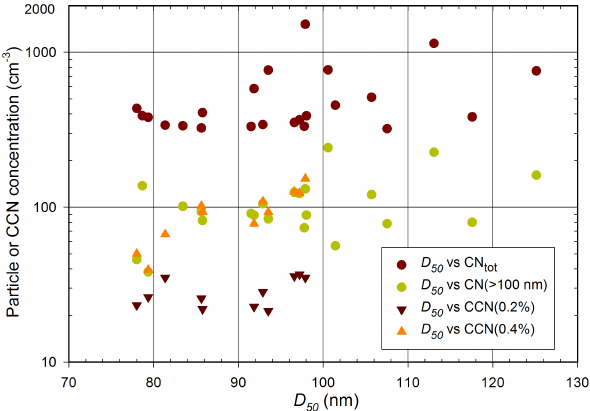
Fig. 3. Cloud droplet concentration (CDNC) versus particle and CCN concentrations (indicated in the legend). A 1:1 line is included as a guide to the